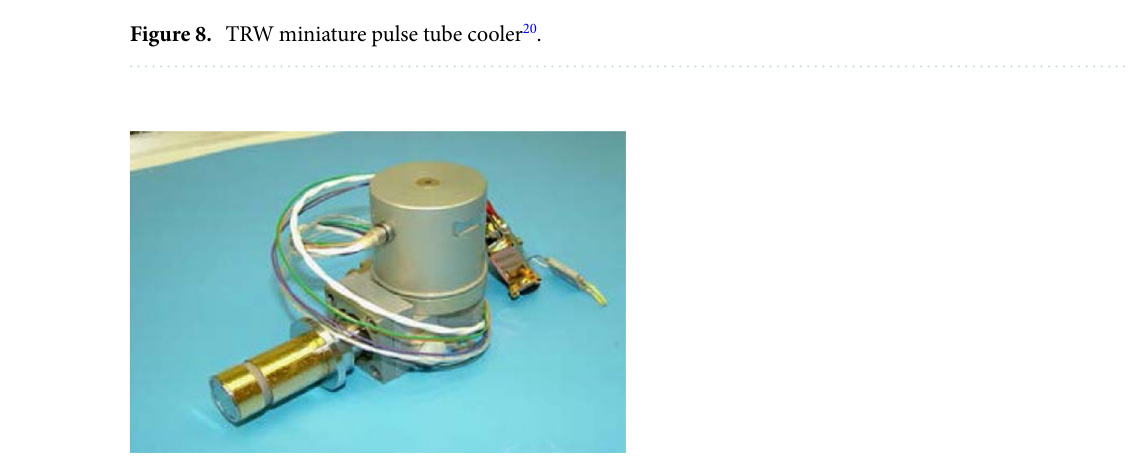
Figure 9. Ricor K508 miniature Stirling cryocooler 21